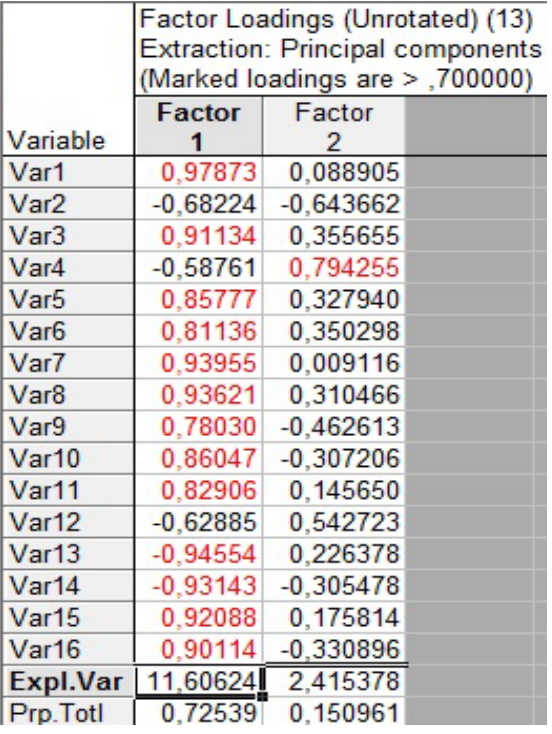
Fig. 5: Results of multivariate analysis to estimate energy efficiency of KNUTD buildings (Listing of STATISTICA10 program) Legend: Var1 - total investment per 1 m²; Var2 - cost estimate for the entire building life cycle; Var3 - territory planning; Var4 - use of renewable energy sources for heating and electricity production; Var5 – indoor climate maintenance; Var6 - use of green building materials; Var7 - use of heat energy; Var8 – use of energy efficient building design principles; Var9 - quality control; Var10 - roof insulation; Var11 - wall insulation; Var12 - floor insulation; Var13 – window heat transfer coefficient; Var14 - air permeability of buildings; Var15 - ventilation; Var16 - heating and